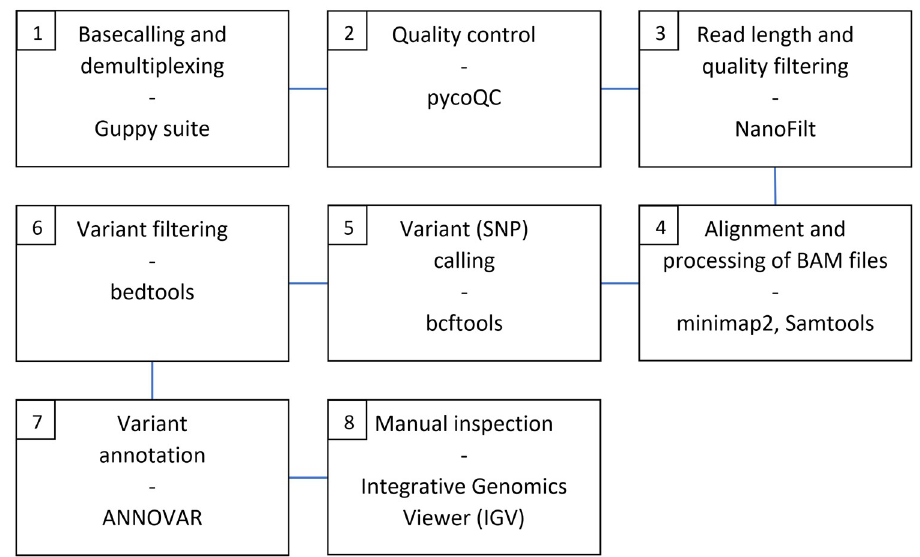
Fig 1. Data analysis pipeline applied for the assessment of the Nanopore sequencing data. Tools used for the different tasks are shown. Step 1 to 7 were implemented in a bash shell script for automation purpose. SNP; single nucleotide